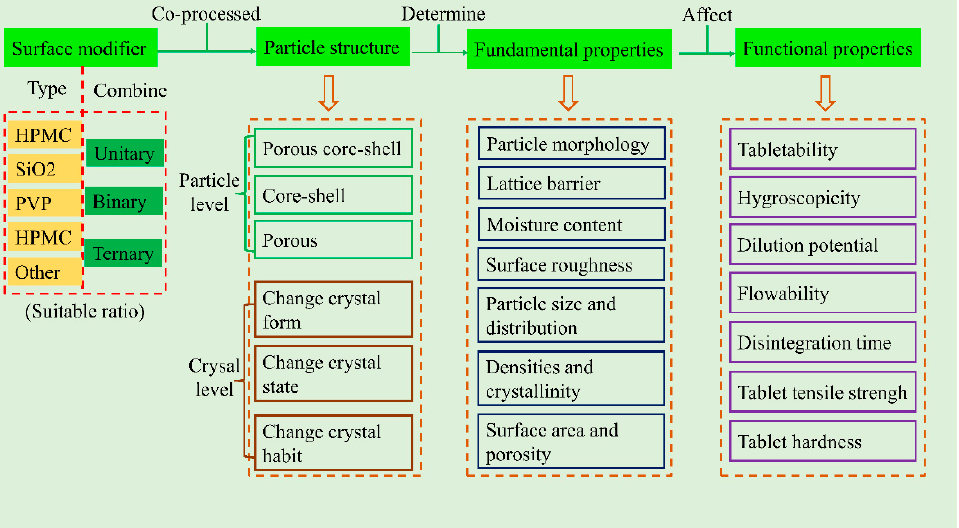
Figure 2. Effects of modifiers on fundamental and functional properties of particles.